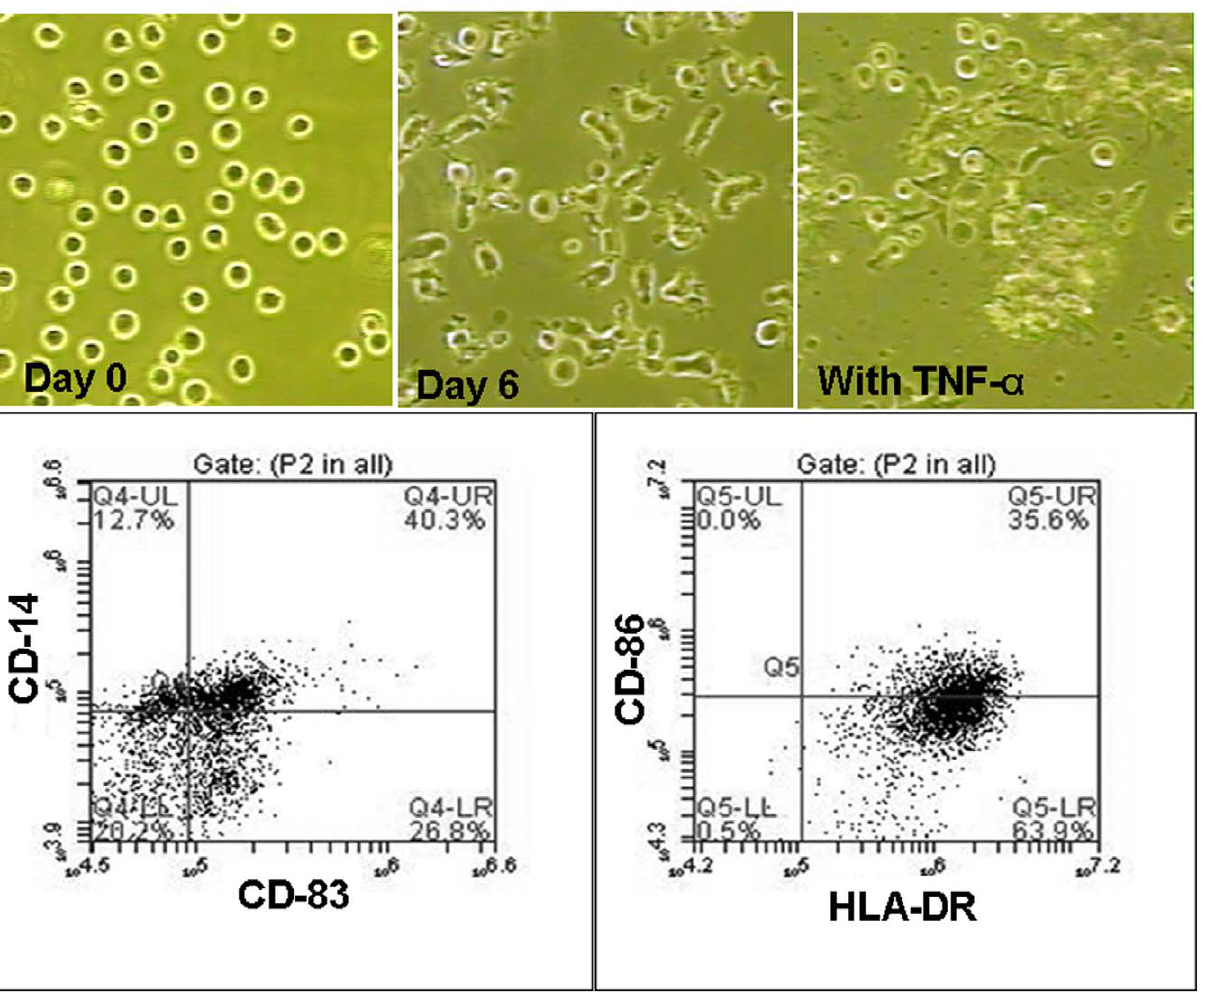
Figure 1. Making of mature dendritic cells from CD14 + cells. Upper panel: Morphological changes in CD14 + cells following the addition of immature and mature dendritic cell (DC) media. Cells were grown in RPMI-1640 media containing 10% FBS, IL4 and GCSF; at day 8 TNF- a was also added. CD14 + cell morphology changed from the rounded cells to the cells exhibiting short dendrite-like processes. Mature DC attached to the growth surface. Lower panel: Multicolor flow cytometric dot plots of CD14 + cells-derived mature DCs at day 11 (3 days after adding TNF- a ) indicate down regulation of CD14 and up regulation of CD86, CD83 and HLA-DR after DCs maturation.